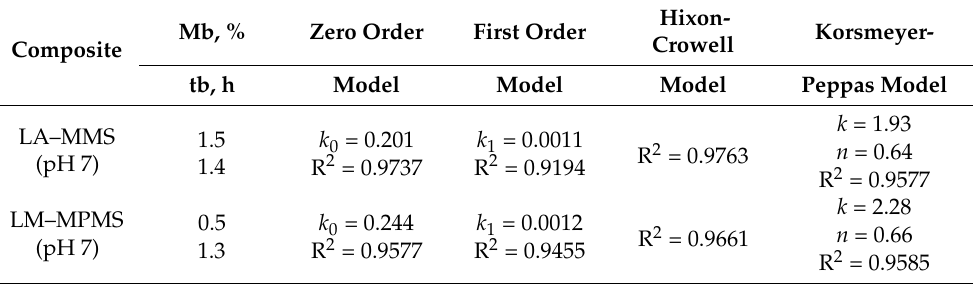
Table 5. Model parameters of LA and LM release from LA–MMS (pH 7) and LM–MPMS (pH 7) composites taking into account the conditions of transit through the